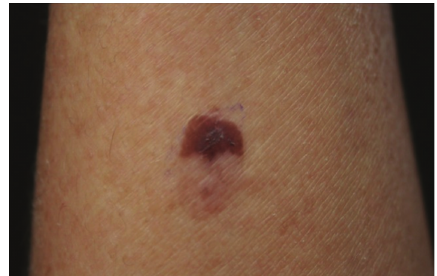
Figure 1: Case 1. Pigmented lesion on the anterior aspect of the forearm.